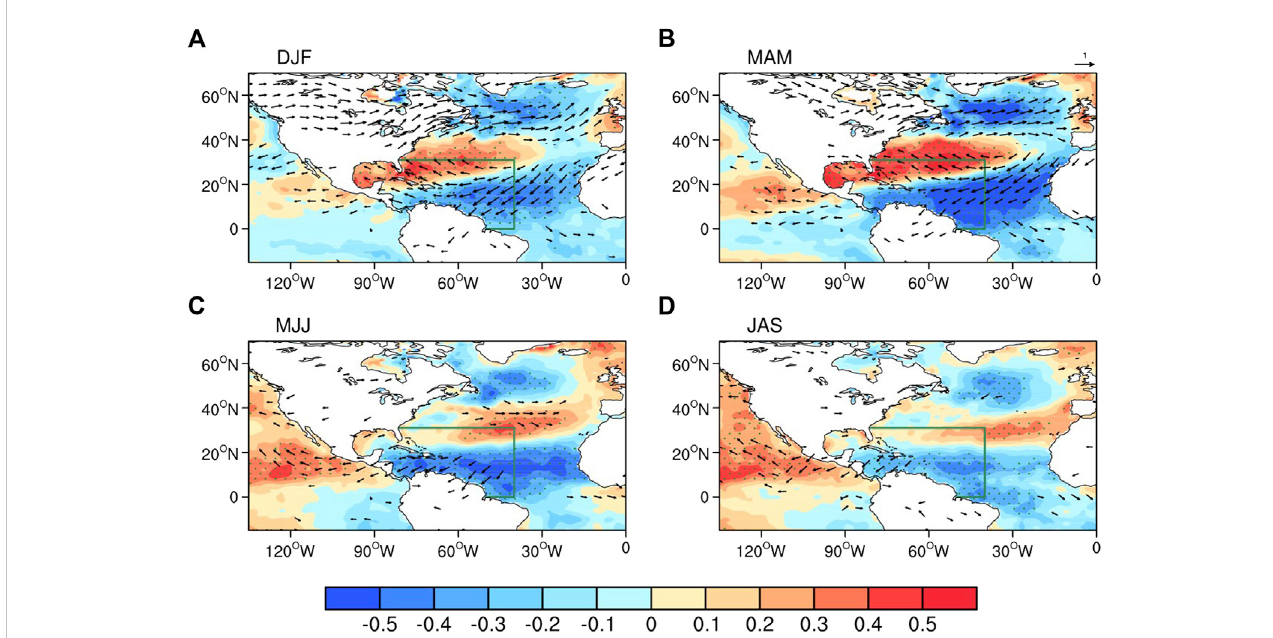
FIGURE 7 Correlation maps of theDJFM – averaged NADIwith the3-monthaverages of SST (shading, units: ° C), surface wind (vectors, units: m\s) anomaliesfor (A) DJF, (B) MAM, (C) MJJ and (D) JAS. Positive (red) and negative (blue) SST anomalies with correlations signi fi cant at or above the 90% con fi dence level are stippled. Only surface wind vectors signi fi cant at the 90% con fi dence level are shown. The green box area indicates the extent of the